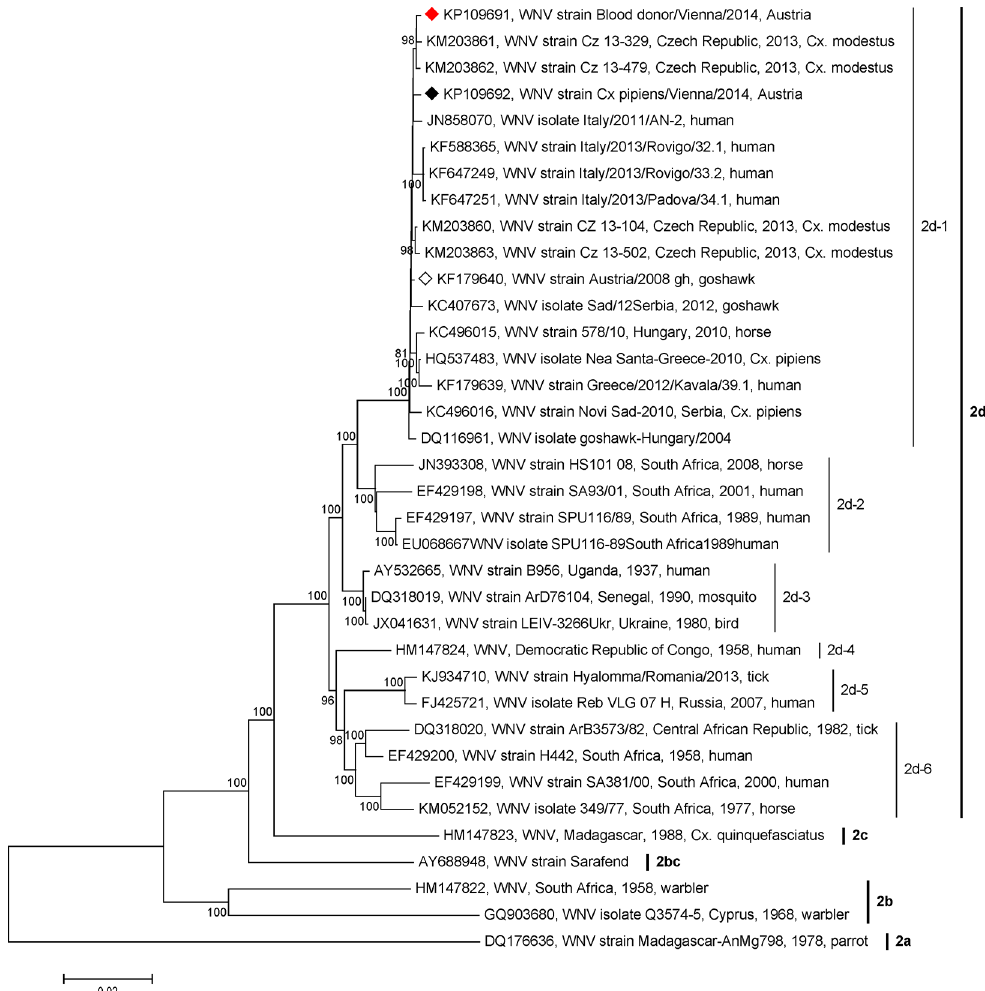
Fig 1. Phylogenetic tree of 36 West Nile virus lineage 2 full length polyprotein-coding nucleotide sequences. The sequences determined in this study are marked with a red diamond (Viennese blood donor-derived WNV) and a black diamond (Viennese Culex pipiens -derived WNV), respectively. The Austrian goshawk-derived sequence from 2008 is marked with a contoured diamond. Five major clades and six clusters among clade 2d are indicated. Group 2d-1 contains the Central/Southern European viruses including Austrian strains, and group 2d-5 consists of the Eastern European WNVs. The phylogenetic tree was constructed using the NJ method with MCL algorithm of MEGA6 [19] with 1,000-fold bootstrap analysis. GenBank accession numbers, strain names, and (if known) species, countries of origins and years of isolations are indicated at the branches. Supporting bootstrap values > 80% (the percentage of replicates in the bootstrap analysis) are displayed next to the nodes. The horizontal scale bar indicates genetic distances (here 2% nucleotide sequence